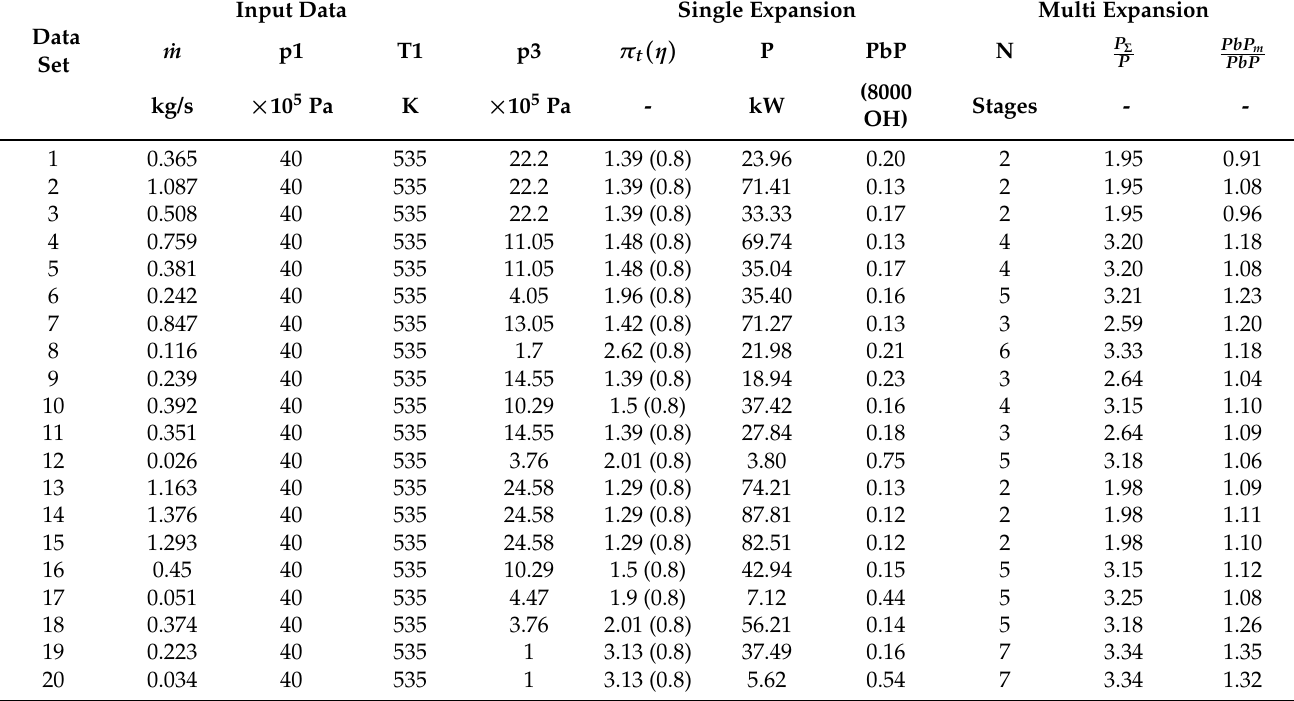
Table A1. Data set from industry steam networks at T1 = 535 K and main results for single and multi expansion. Input